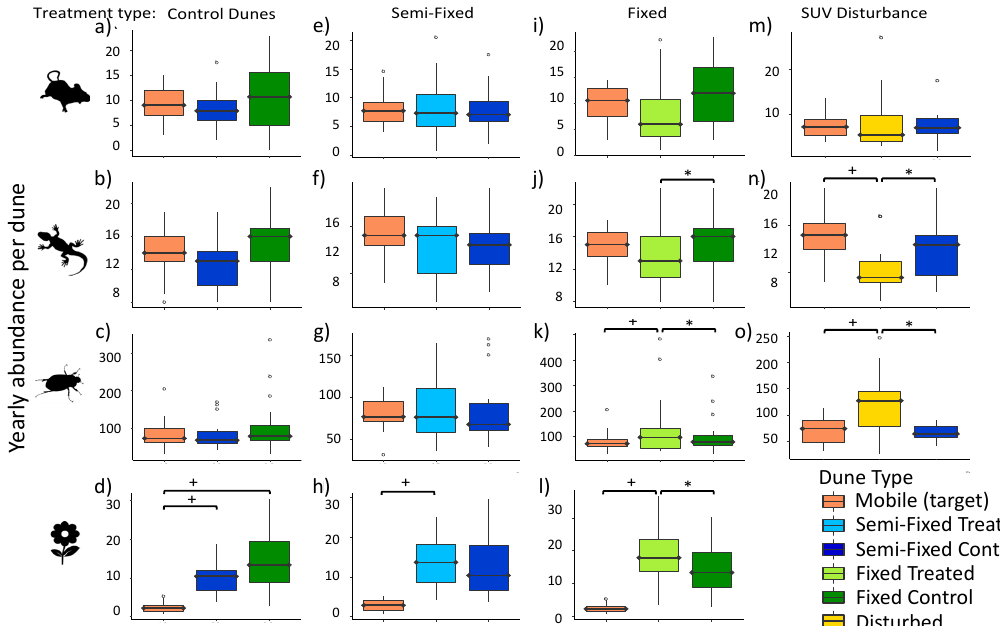
Figure 2. Boxplots of average abundance for each taxon (see taxonomic icons by row) for ( a – d ) control dunes, ( e – h ) semi-fixed dune treatment, ( i – l ) fixed dune treatment, and ( m – o ) o ff -road sport and vehicle disturbance. Each treated dune type was tested against its untreated pair (control) and mobile (reference) dunes. Disturbed dunes were not monitored for annuals, and untreated semi-fixed dunes were used as the control. Significant di ff erences were tested with generalized mixed models for beetles and reptiles (Poisson), and linear mixed models for rodents and annuals. p < 0.05 for treated dunes compared to * control and + reference